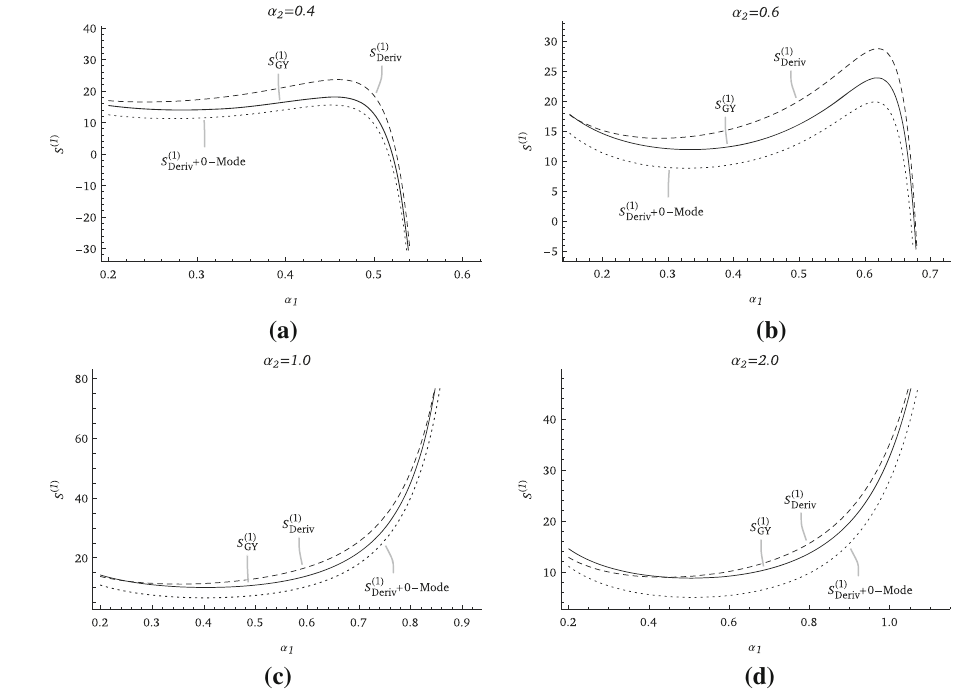
Fig. 5 Comparison of the derivative expansion with the Gelfand–Yaglom method for the scalar determinant. Figure a assumes α 2 = 0 . 4; Fig. b α = 0 . 6; Fig. c α = 1 . 0; and 2 2 Fig. d α 2 = 2 . 0. The α 1 scales are different because the range is ≤ α restricted to α 2 2 . The zero 1 ˜ S 3 (α) log , mode factor is ( − 1 ) 3 2 2 π where S 3 = β ˜ S 3